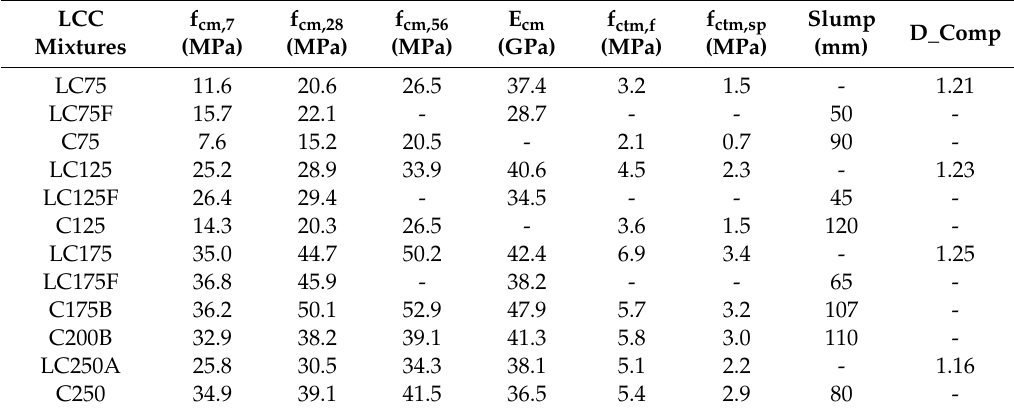
Table 2. Mechanical properties of studied concretes.